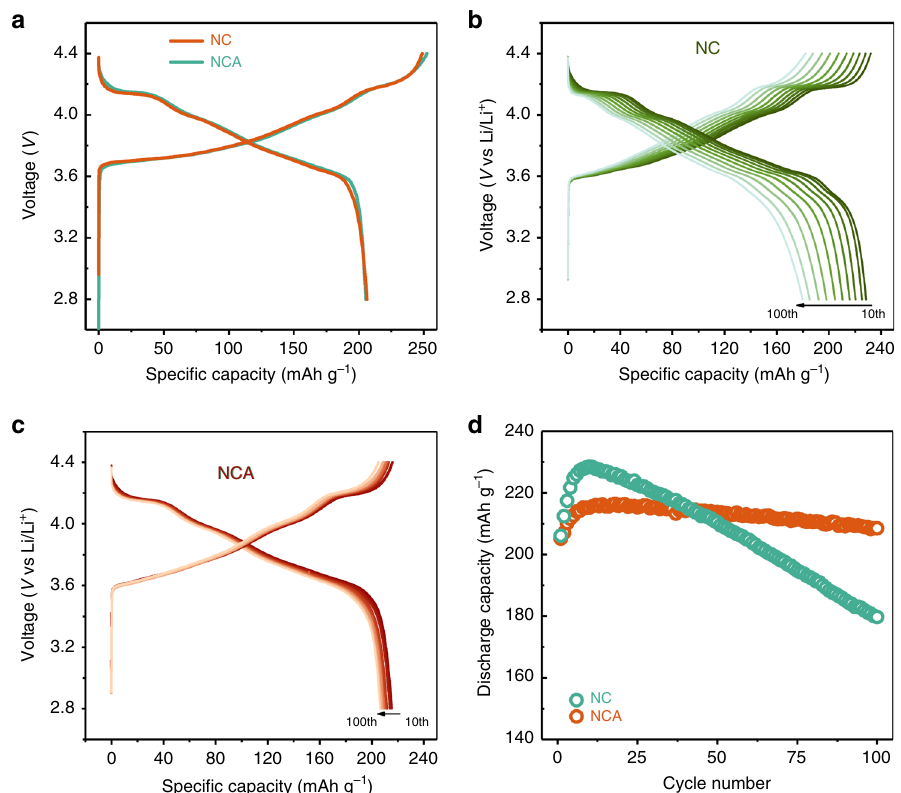
Fig. 2 Electrochemical cycling performance of NC and NCA measured in half-cell. a The fi rst charge – discharge cycle at the voltage between 2.8 and 4.4 V. The red and green lines represent the plots of NC and NCA, respectively. The charge – discharge pro fi les of b NC, c NCA, from 10th to 100th cycles. d Discharge capacity evolution as a function of cycle numbers. Each red and green ring represents the capacity of NCA and NC collected from 1st to 100th